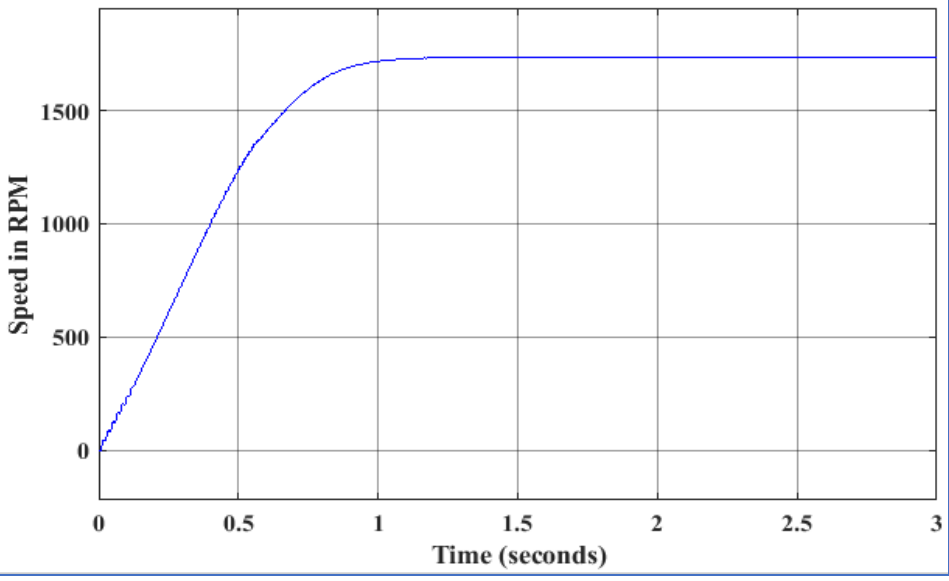
Figure 10. Speed of single stage SLMLI fed induction motor.